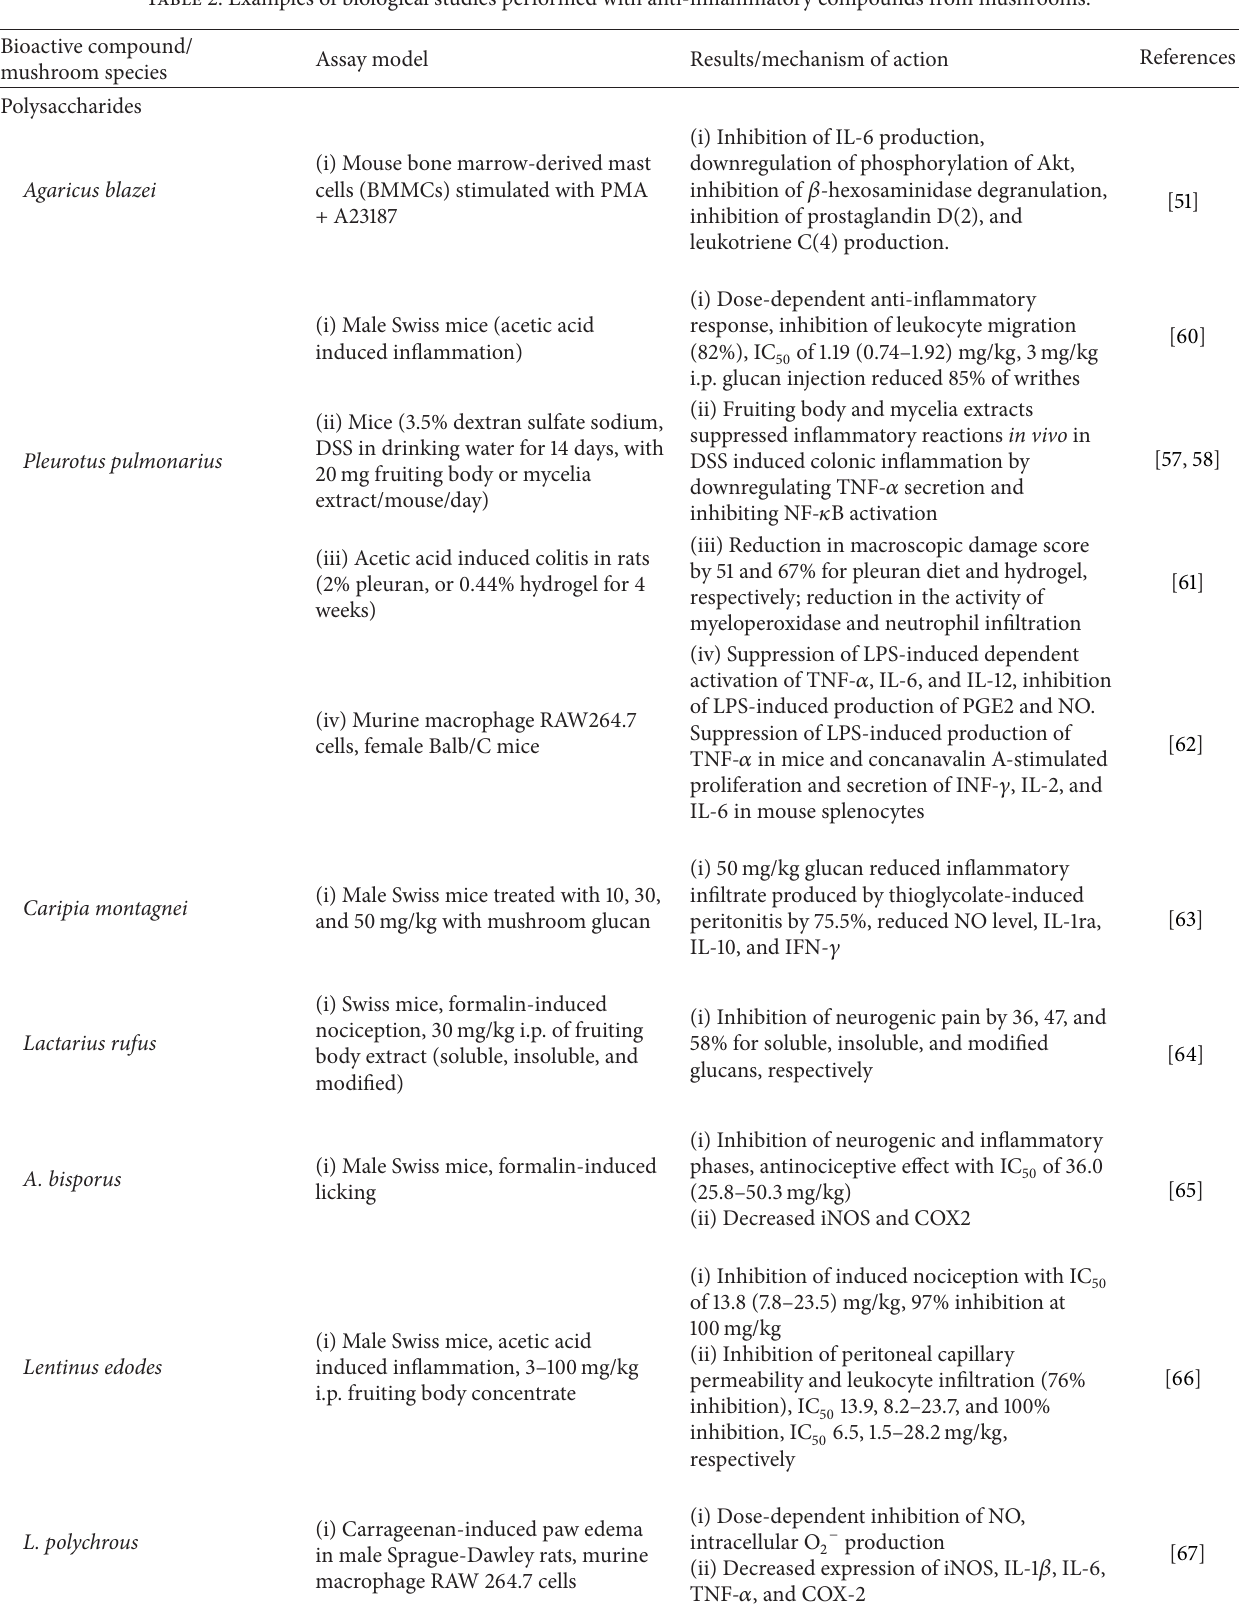
Table 2: Examples of biological studies performed with anti-inflammatory compounds from